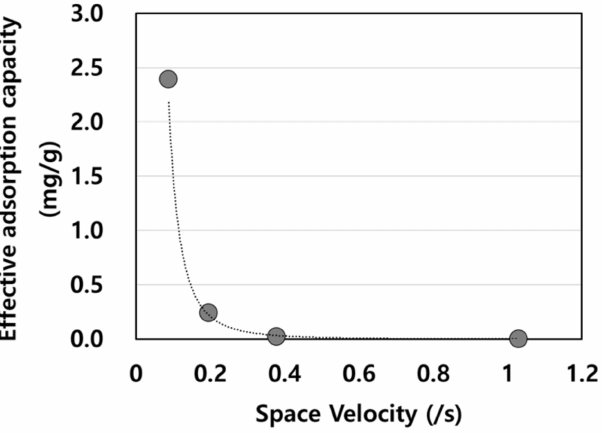
Figure 4. Effective adsorption capacity of NH 3 based on space velocity.